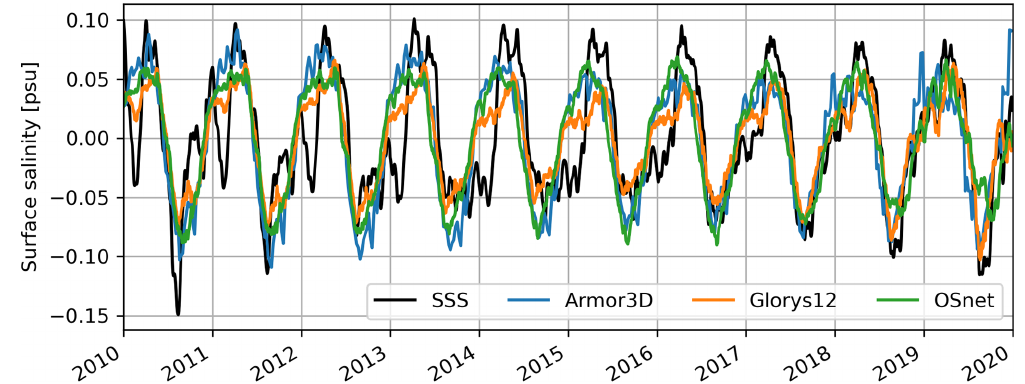
Figure A1. Periodic signal of the mean surface salinity from OSnet (green), Glorys12 (orange), Armor3D (blue) and remote sensing (black). The periodic signal is extracted using an STL decomposition. The SSS seasonal variation is delayed each year in winter until the 2017–2018